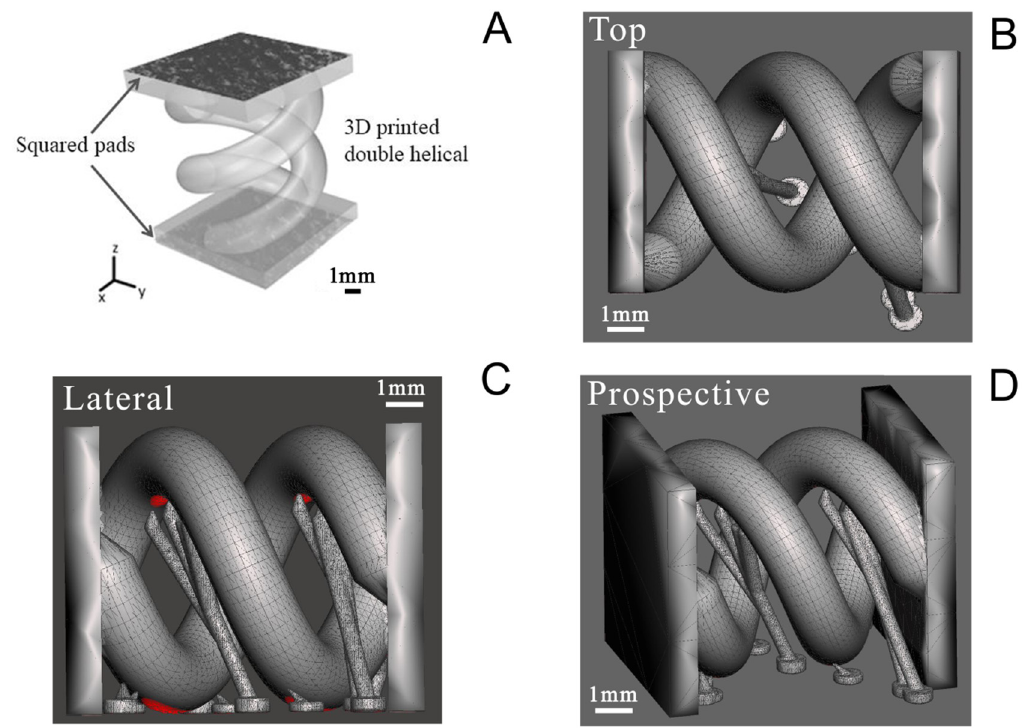
Figure 1. Computer-aided design drawing of double helix structure. ( A ) General view showing the pads for contact during electrical characterization; ( B ) top view; ( C ) lateral view; and ( D ) prospective view.